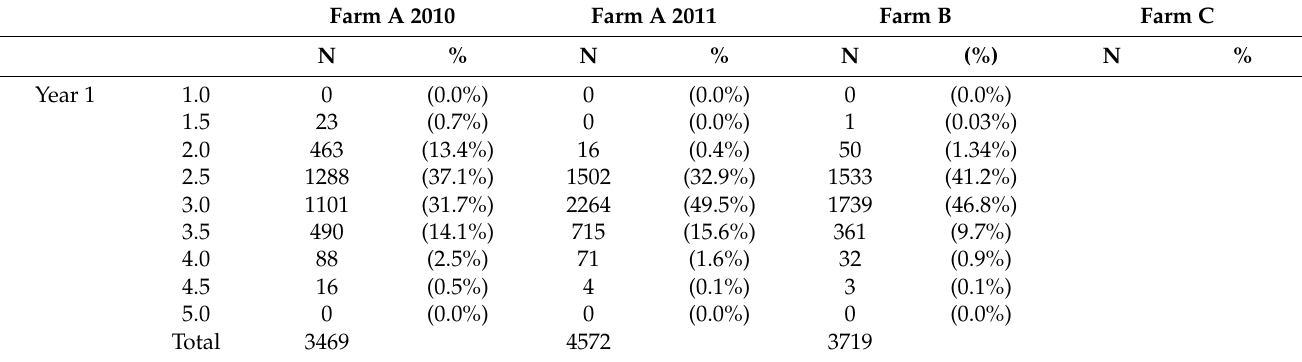
Table A3. Of the ewes that had a pre-mating body condition score (BCS) recorded 1 , the number (N) and percentage (%) of ewes in each of the BCS categories (1.0–5.0), for each enrolled cohort (Farm A 2010, Farm A 2011, Farm B and Farm C) for each study